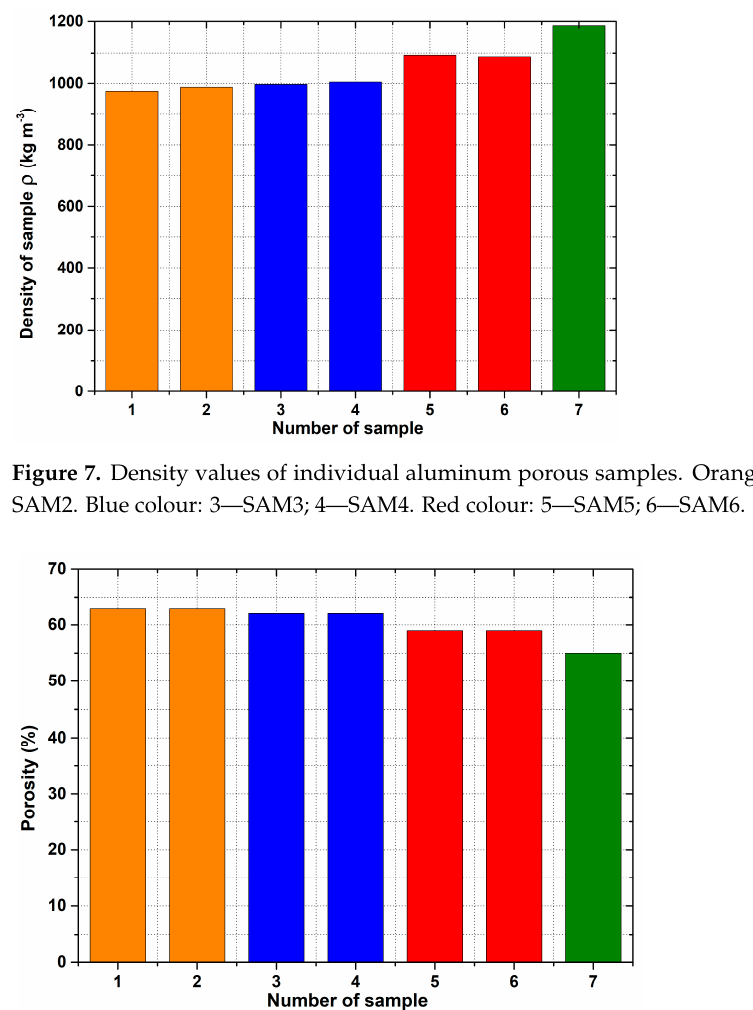
Figure 8. Porosity values of individual aluminum porous samples. Orange colour: 1—SAM1; 2—SAM2. Blue colour: 3—SAM3; 4—SAM4. Red colour: 5—SAM5; 6—SAM6. Green colour: 7—SAM7.